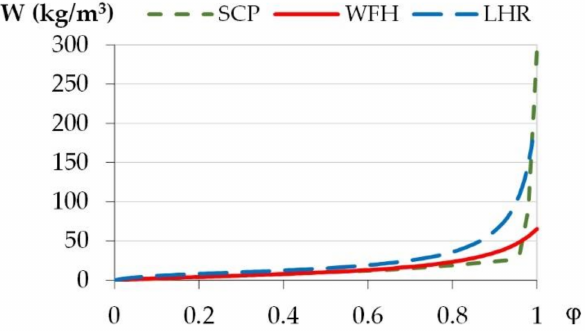
Figure 7. The sorption curves of